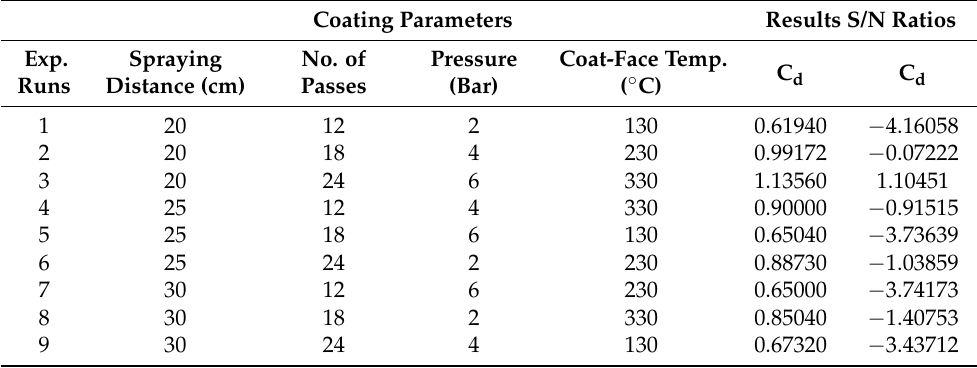
Table 4. Results of the experiments and the calculated S/N